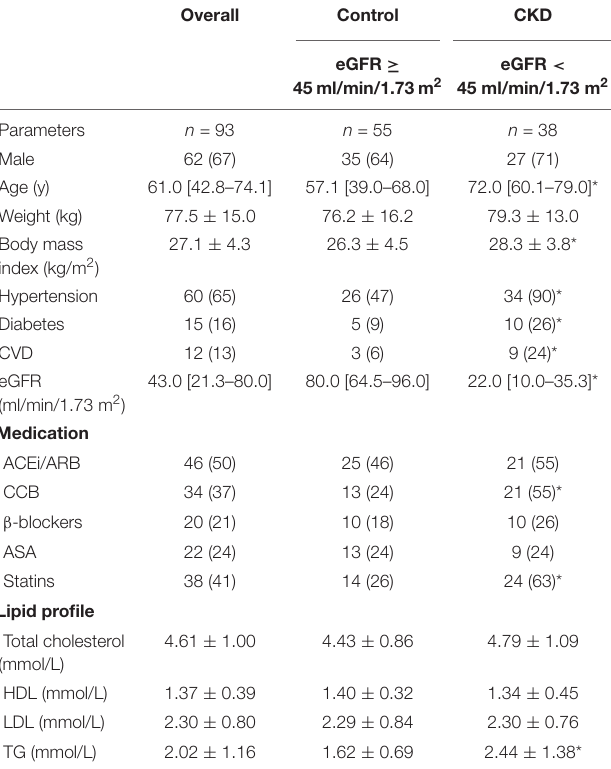
TABLE 2 | Nitroglycerin-induced changes in brachial pressures and regional arterial